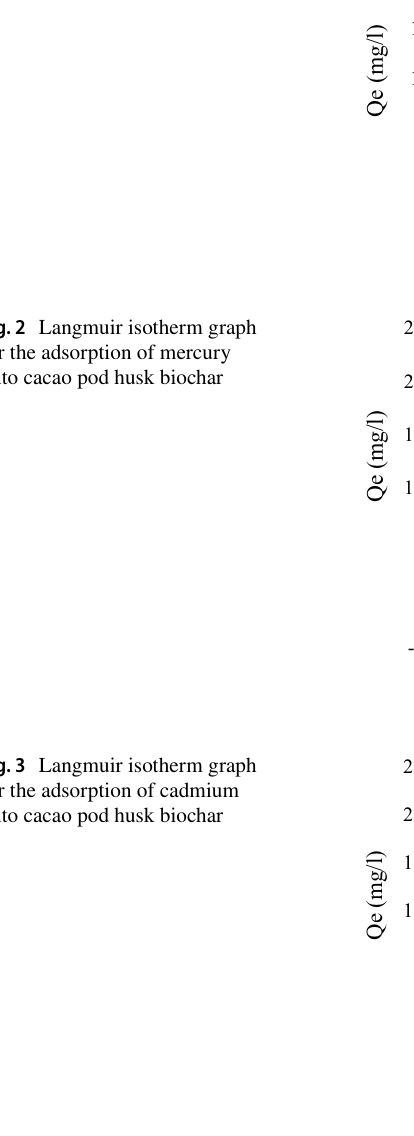
Fig. 2 Langmuir isotherm graph for the adsorption of mercury onto cacao pod husk biochar